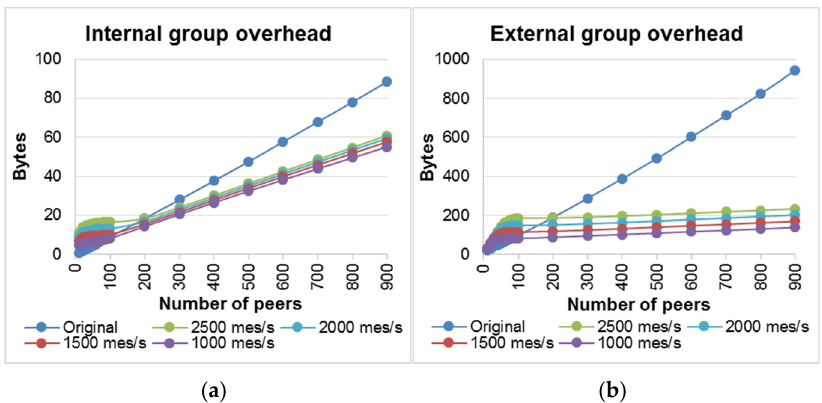
Figure 7. Internal ( a ) and external ( b ) group overheads in bytes for a system with delays from 0 to 50 milliseconds.